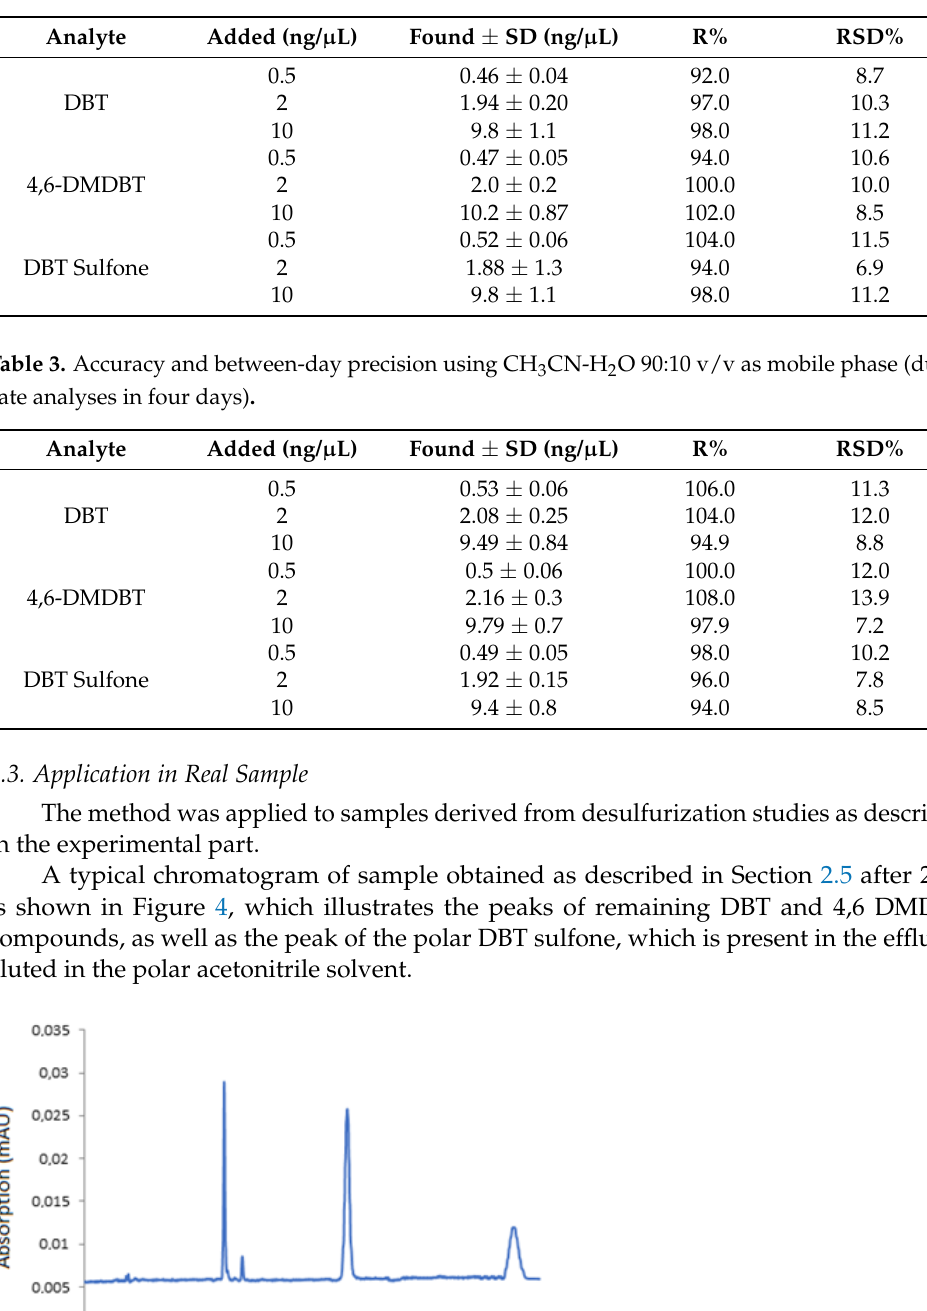
Table 2. Accuracy and repeatability using CH 3 CN-H 2 O 90:10 v/v as mobile phase n = 3 .